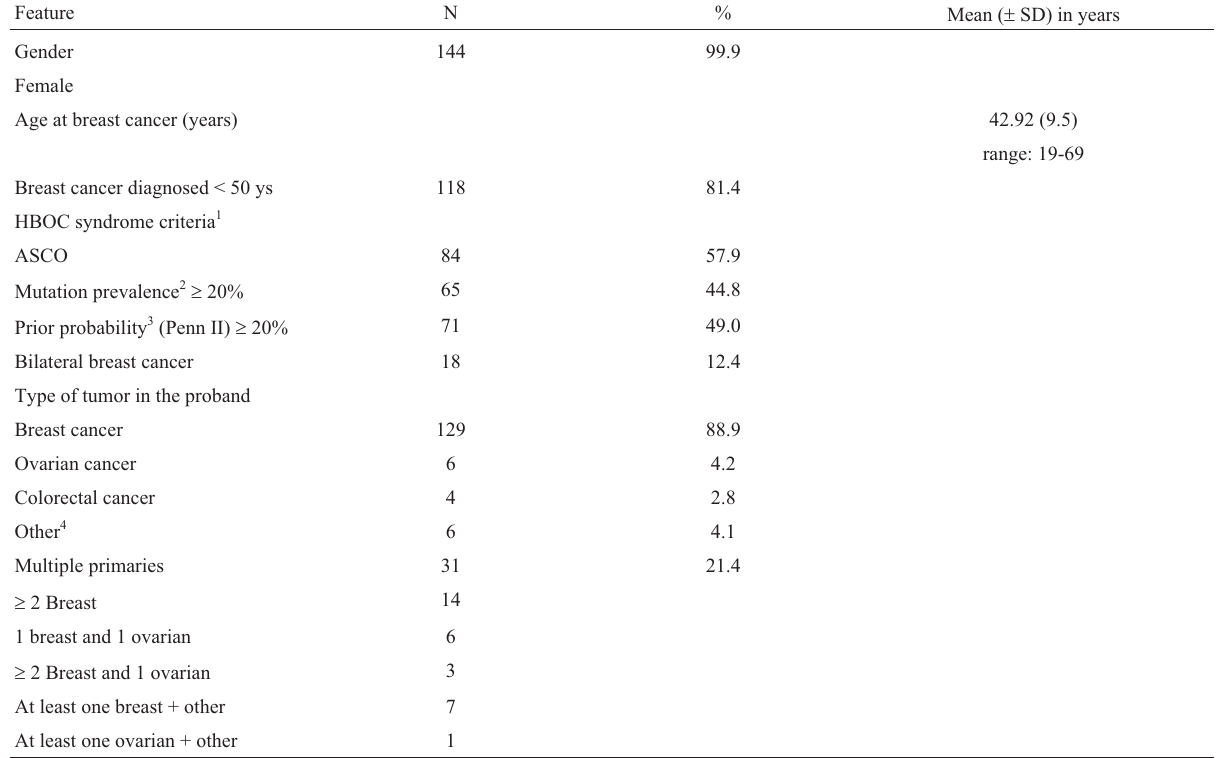
Table 1 - Clinical characterization of the series (n = 145) of HBOC patients included in this